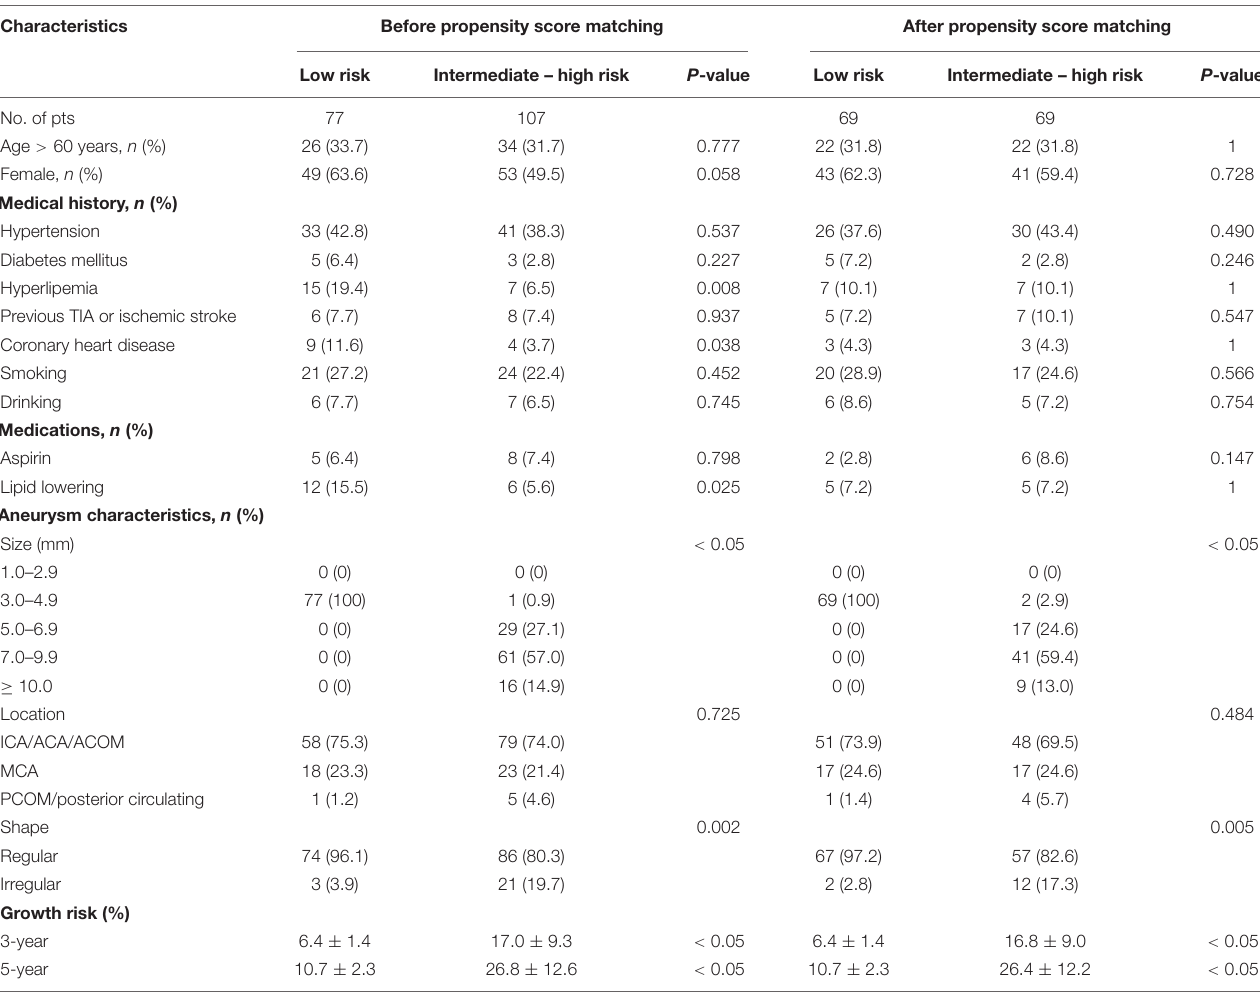
TABLE 1 | The characteristics of patients and UIAs.